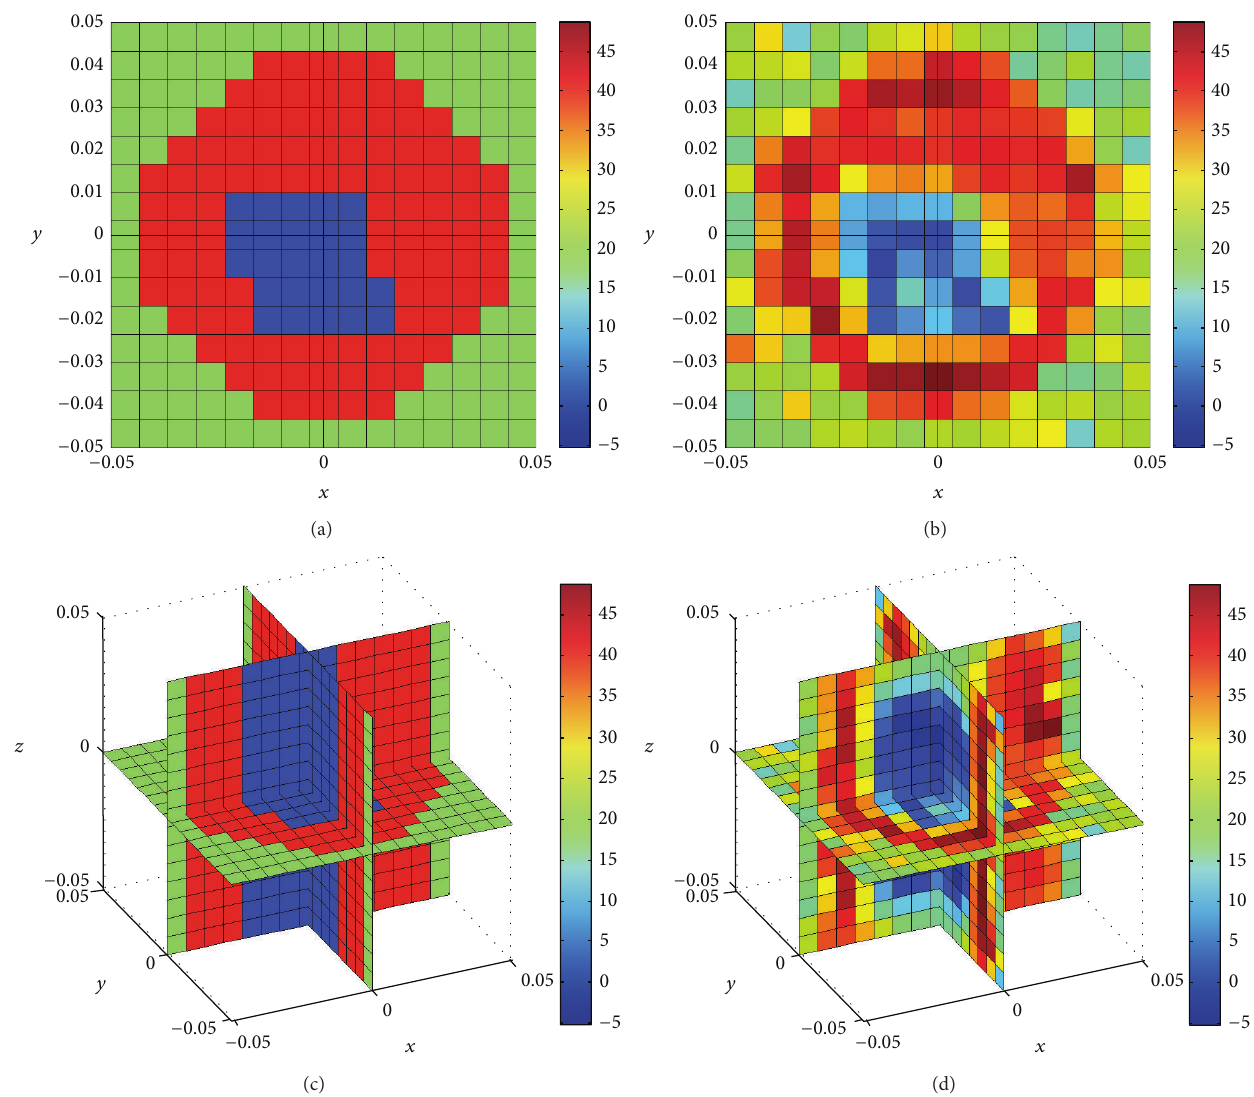
Figure 6: − Imaginary part of the exact permittivity used to simulate the data at 1GHz with a SNR of 30 dB (left) and of the reconstructed permittivity (right) for the adult’s arm phantom, in the 𝑥𝑦 -plane (top) and in three perpendicular planes (bottom). Distances are in m.